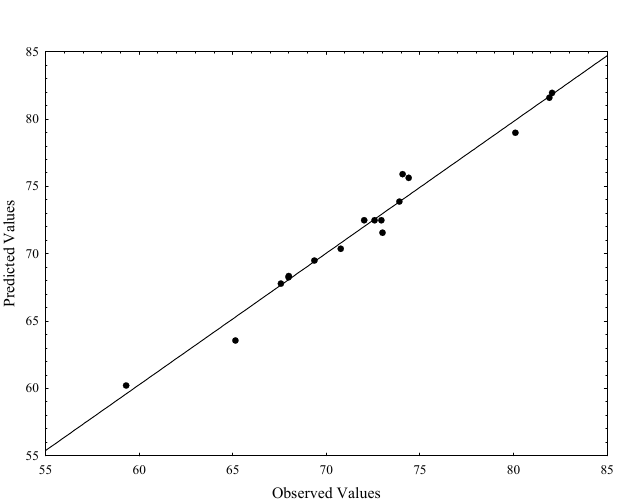
Figure A1. Correlation between experimental ( observed values ) and fitted ( predicted values ) ester yields (wt.%) of the esterification/transesterification with SODD saponifiable phase and ethanol using Eversa Transform 2.0 as biocatalyst.